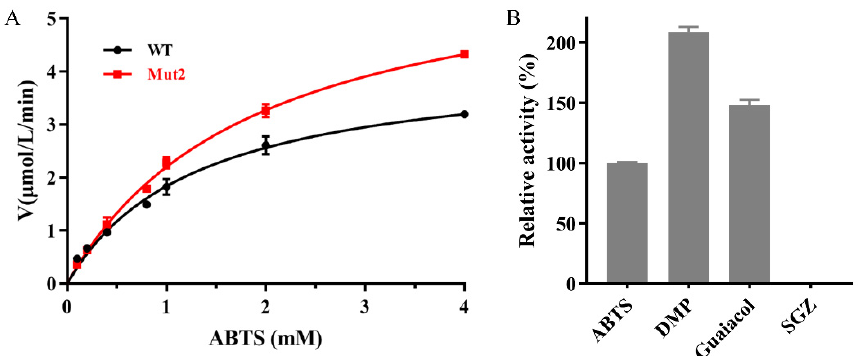
Figure 2. Kinetic analysis of Ghlac ( A ) and substrate specificity of Mut2 ( B ). ABTS, DMP, and SGZ were the abbreviations of 2,2 ′ -azino-bis(3-ethylbenzthiazoline)-6-sulfonate, 2,6-dimethoxyphenol, and syringaldazine, respectively. K m and k cat of Ghlac WT were 1.3 mM and 125.7 min − 1 (4.1 U/mg),